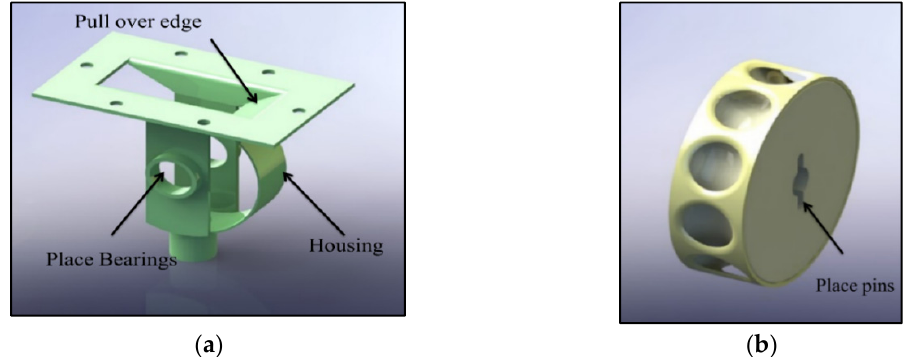
Figure 6. ( a ) Lining the housing and its di ff erent sections; ( b ) rolling distributor.